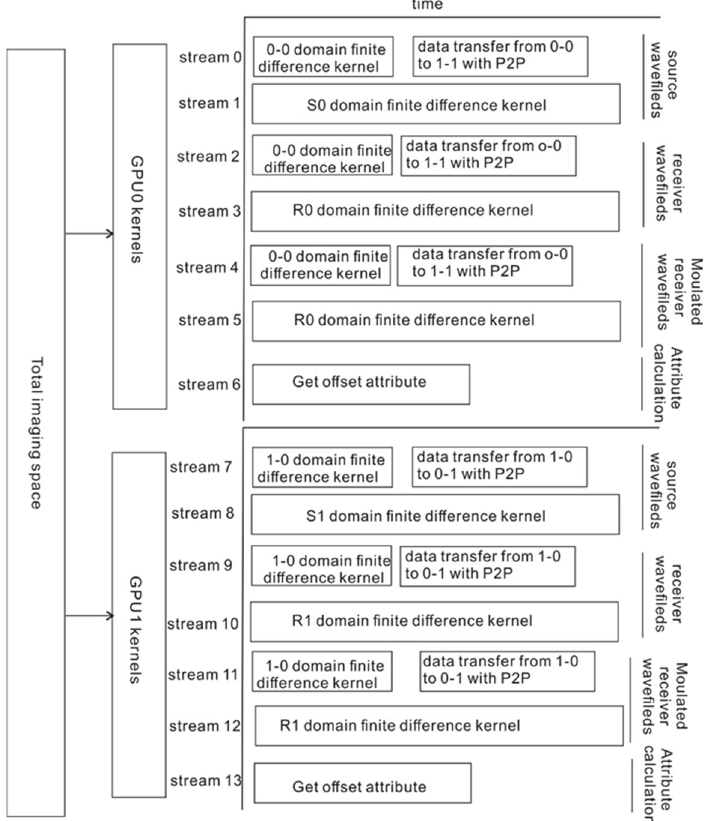
Figure 8. The process flow for RTM calculation of SOGs on dual GPUs.